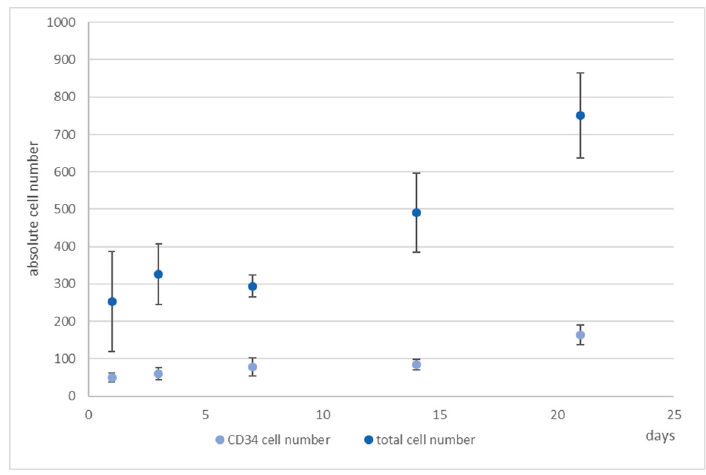
Figure 6. 4D cell count of hHSCs and hMSCs in co-culture over the indicated time period after indirect immunofluorescence staining of CD34 + cells ( medium blue ) and determination of total cell count ( light blue ) with propidium iodide counterstaining and subsequent software based counting. As can be seen, the total cell number tripled with the ratio of hHSCs:hMSCs kept constant. Used antibodies for CD34 + cell detection: CD34 mouse anti-human, ab762, Abcam, and goat-anti-mouse-AlexaFluor488, AC-11001, ThermoFisher Scientific.